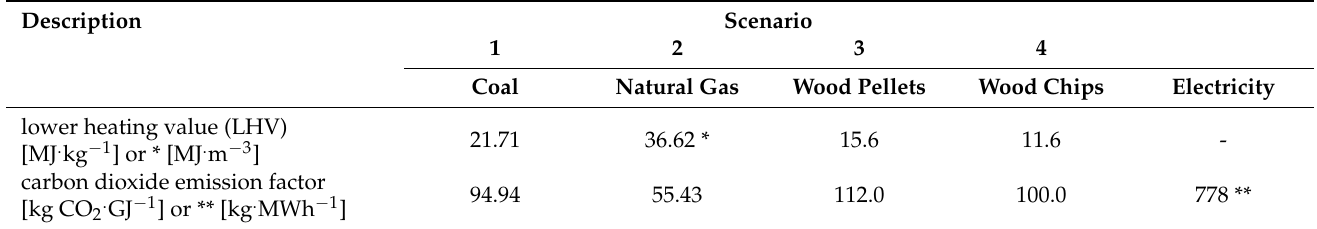
Table 2. The lower heating value (LHV) and carbon dioxide emission factor